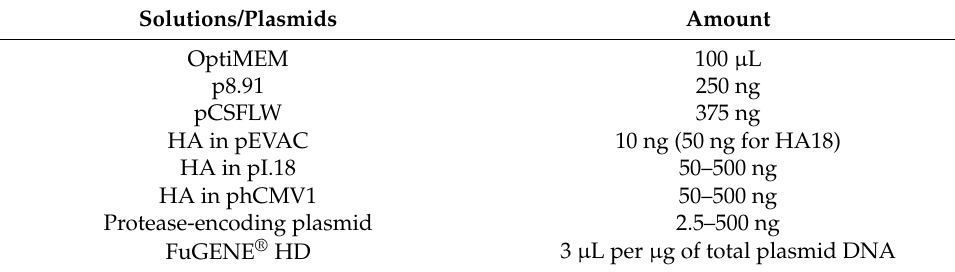
Table 1. Amounts of Influenza HA transfection